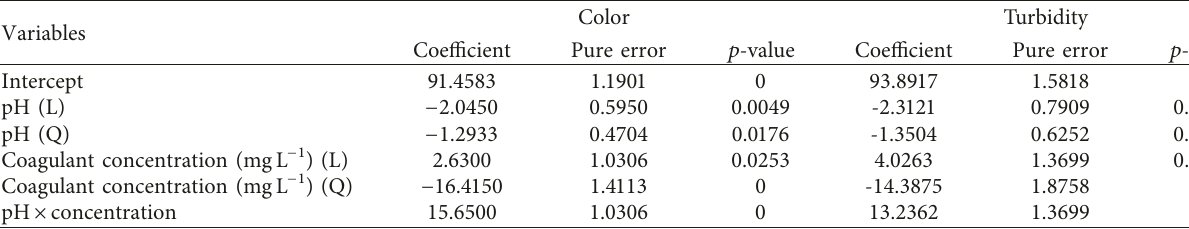
Table 6: Effects for the removal of color and turbidity of the wastewater (batch 1). Variables